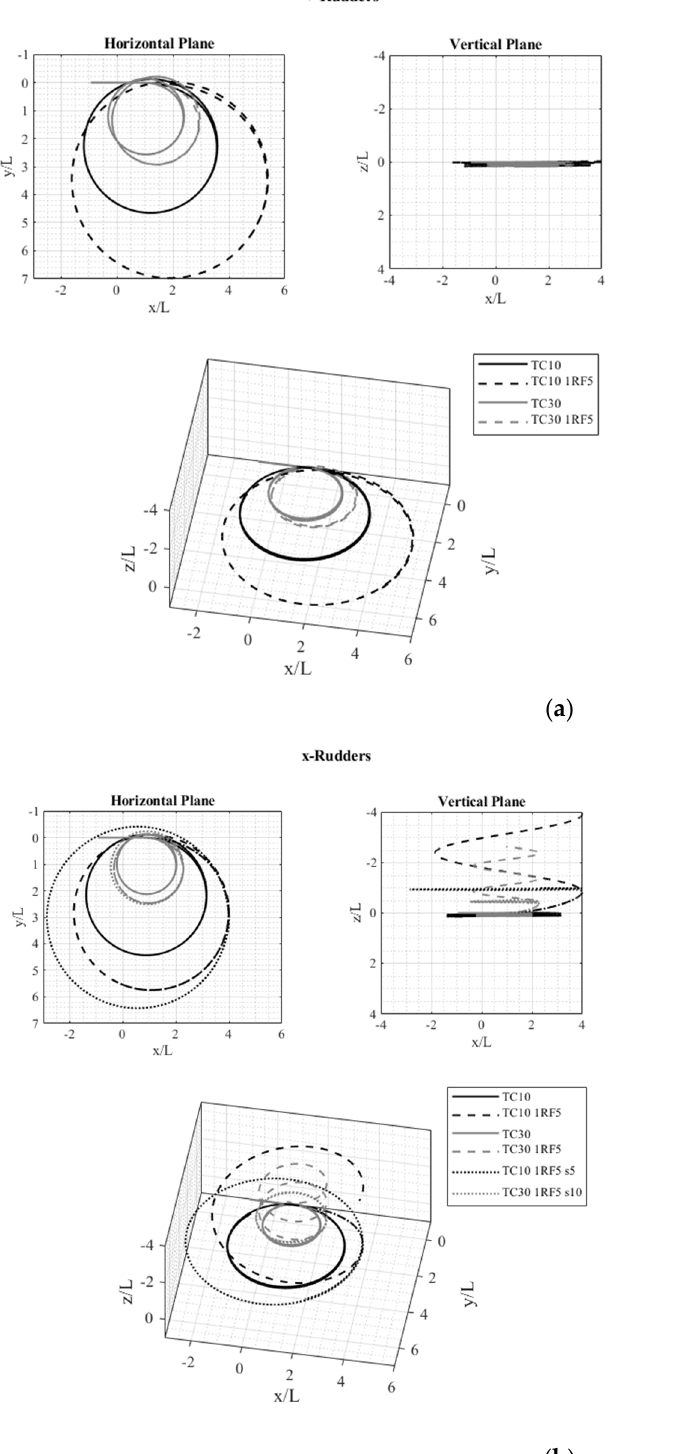
Figure 17. ( a ): SMG +-Eq—Turning circles in #1 plane jammed or lost condition. ( b ): SMG x-Eq— Figure 17. ( a ) SMG +-Eq—Turning circles in #1 plane jammed or lost condition. ( b ) SMG x-Eq— Turning circles in #1 plane jammed or lost condition. Turning circles in #1 plane jammed or lost